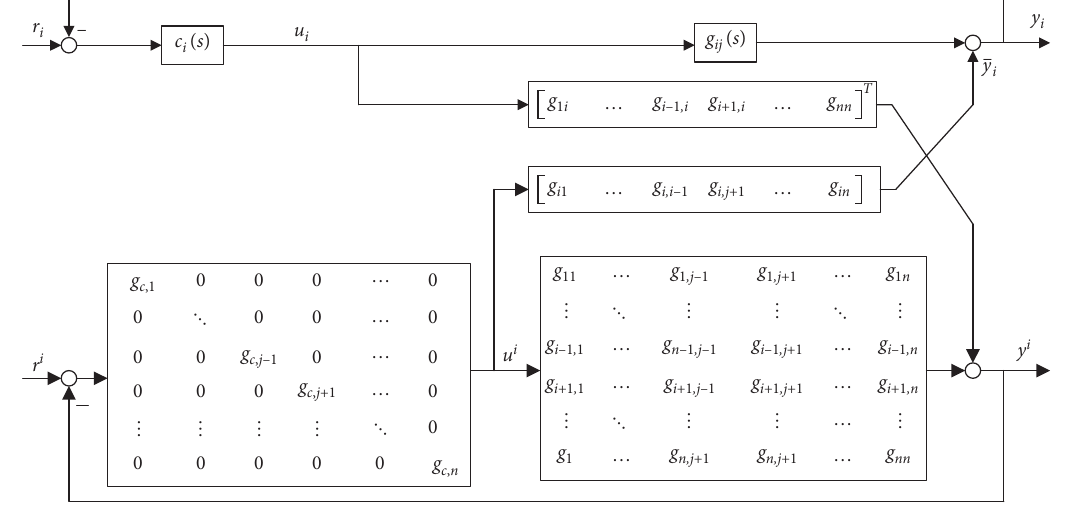
Figure 1: Block diagram for the concept of the